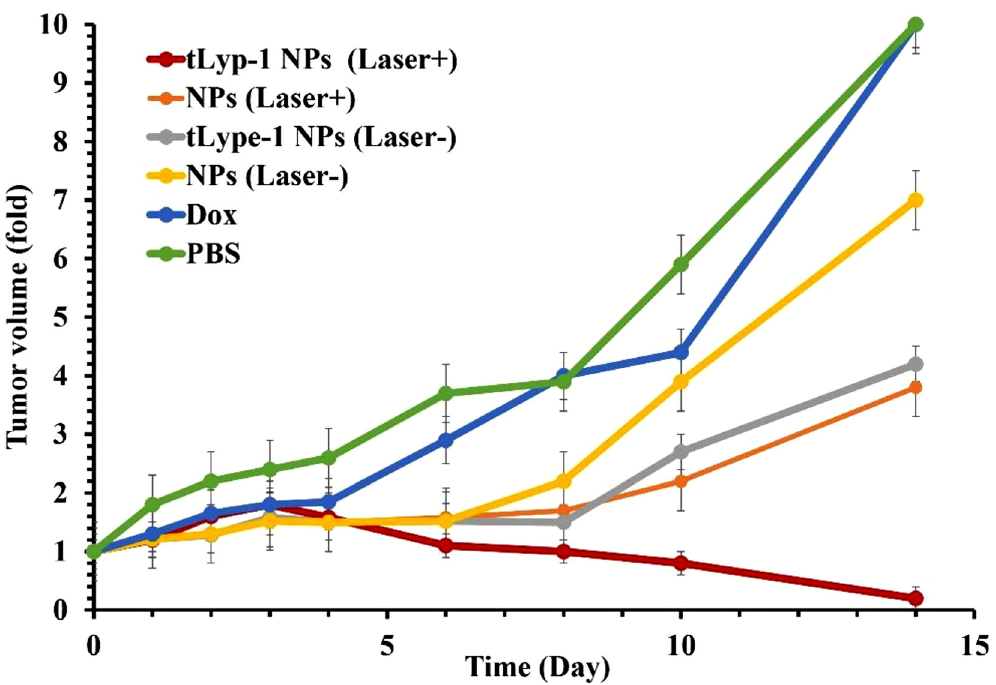
Figure 9: Tumor growth curves showing the antitumor efficiency of PBS, Free Dox, NPs with Ce6, and Dox without tLyp-1 in the surface (NPs), NPs with Ce6 and Dox with tLyp-1 in the surface (tLyp-1 NPs) with (Laser + ) or without (Laser − ) irradiation (170 mW cm − 2 for 9.8 min, 660 nm). Adapted from Jiang et al.